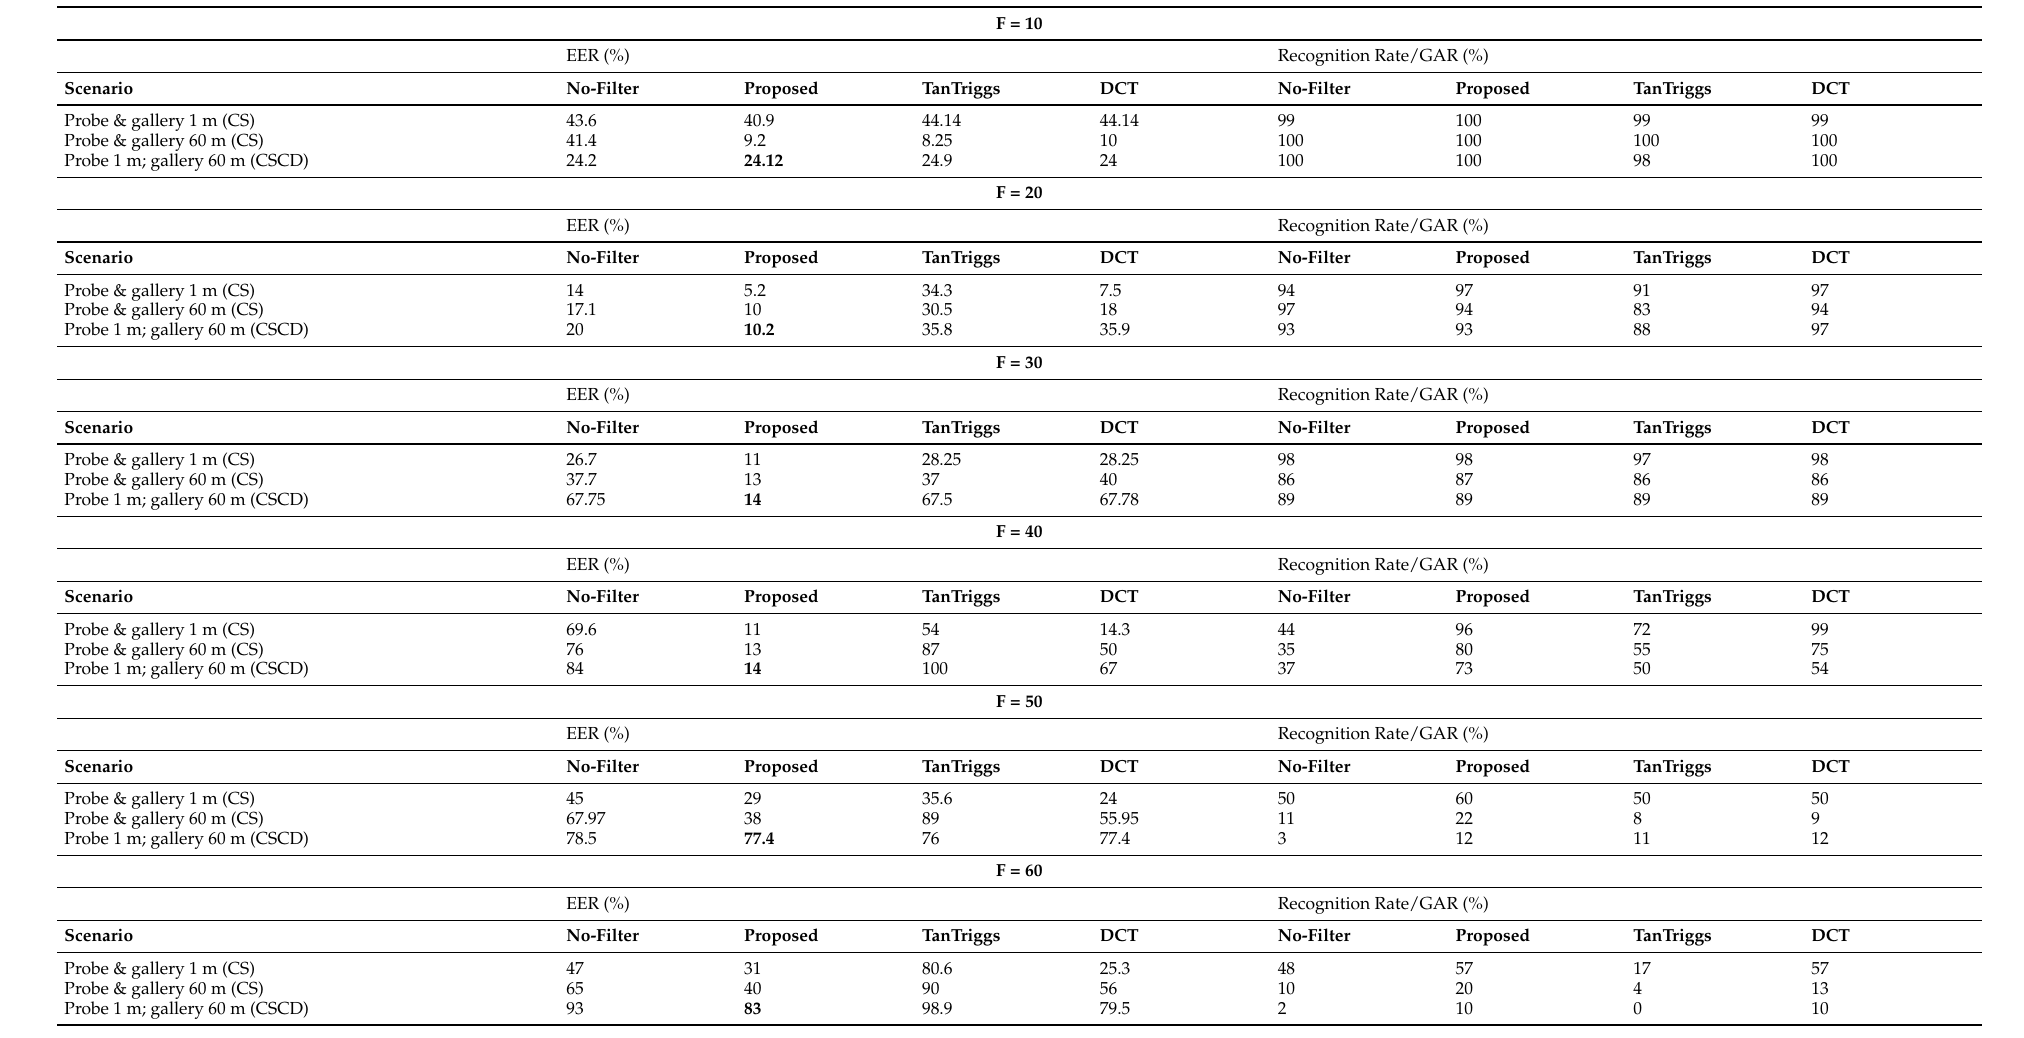
Table 1. Effects of BLPOC FB variation on filtering operation in CS and CSCD face